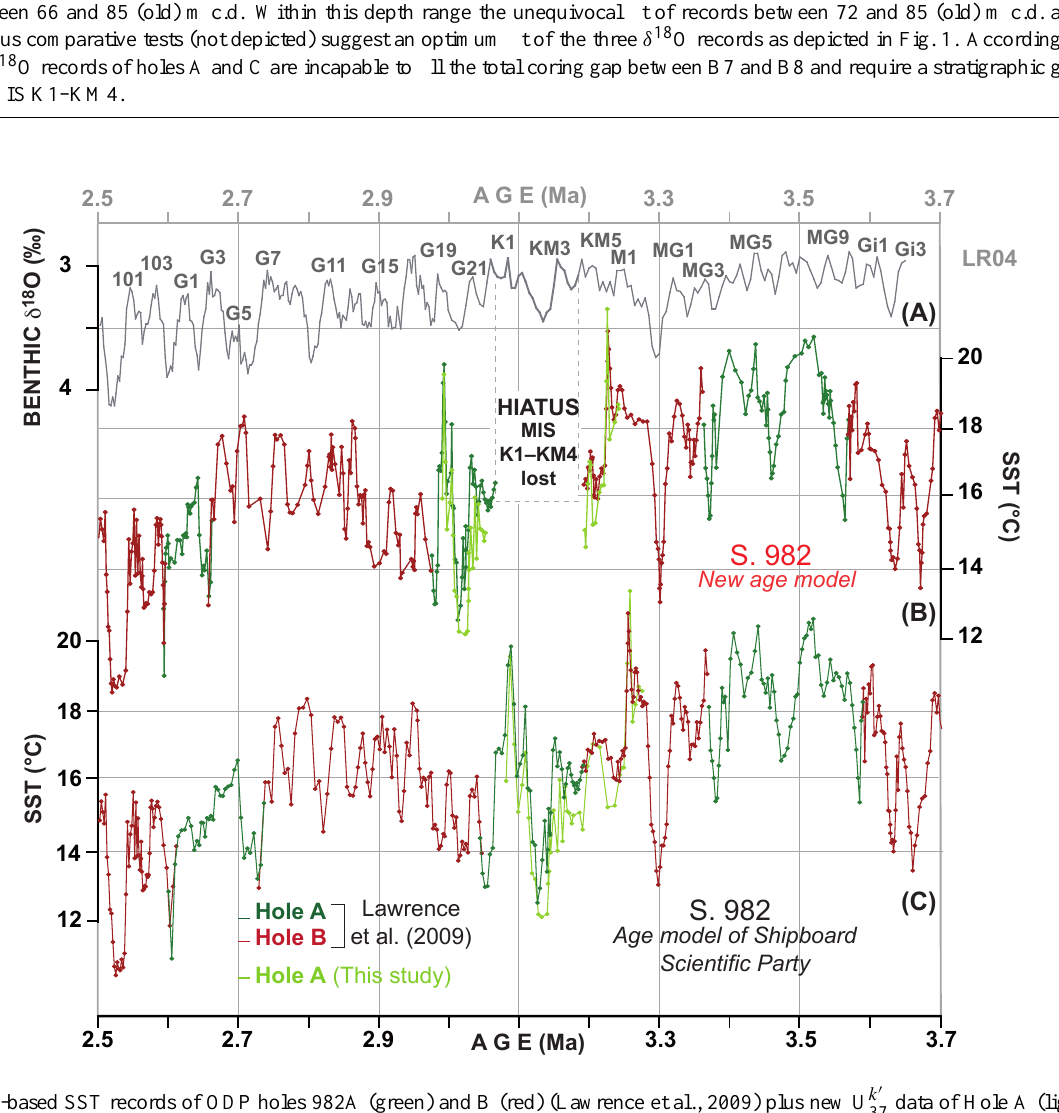
0 Fig. 3. U k -based SST records of ODP holes 982A (green) and B (red) (Lawrence et al., 2009) plus new U k 37 (suppl. by this study), plotted both on the new (B) and previous (C) age scales and versus (A) the δ 18 O global ice volume record LR04 (Lisiecki and Raymo,